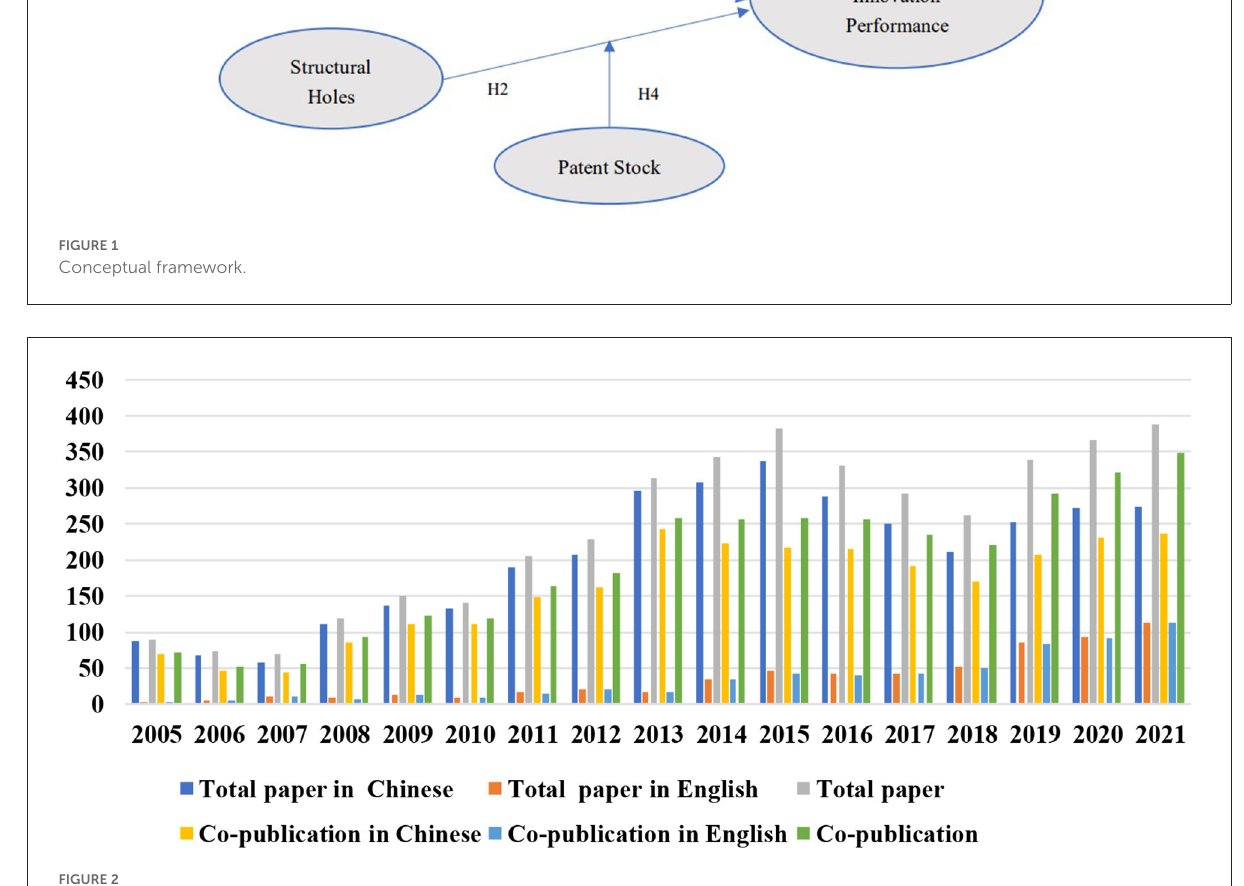
the patent data was obtained from the CNIPA patent search and analysis database in